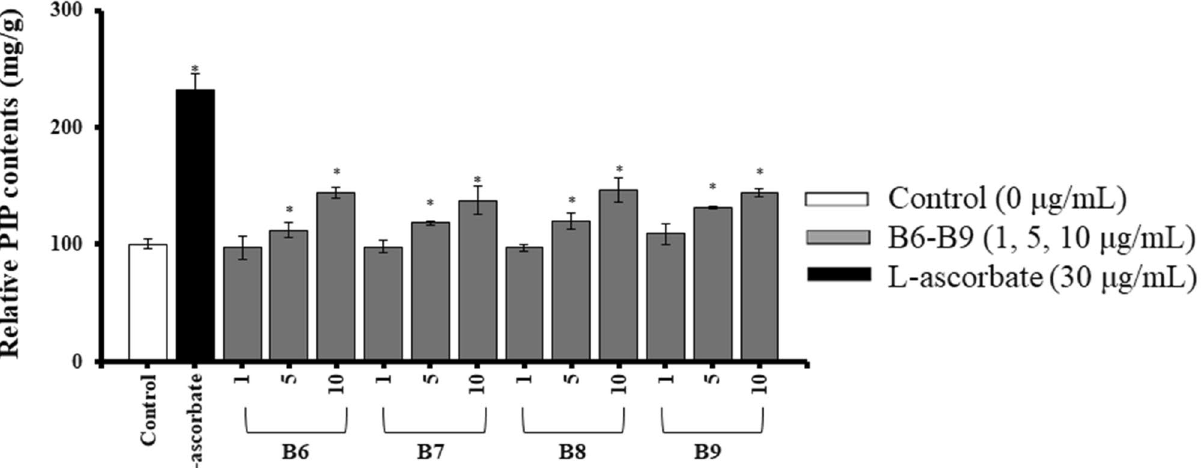
Figure 2. Relative PIP contents 1 in human dermal fibroblasts (HDFs) after treated with different concentrations of group B6 to B9. The data are expressed as mg/g when vehicle control is set to 100 mg/g (Mean ± SD, * p < 0.05, Vehicle control vs. Sample extracts vs. Positive control 2 ). 1 Relative PIP contents: The relative PIP contents in HDFs cells after treatment when the relative PIP content of vehicle control is set to 100 mg/g. 2 Positive control: l-ascorbate. Chart was drawn by Prism Software 4.